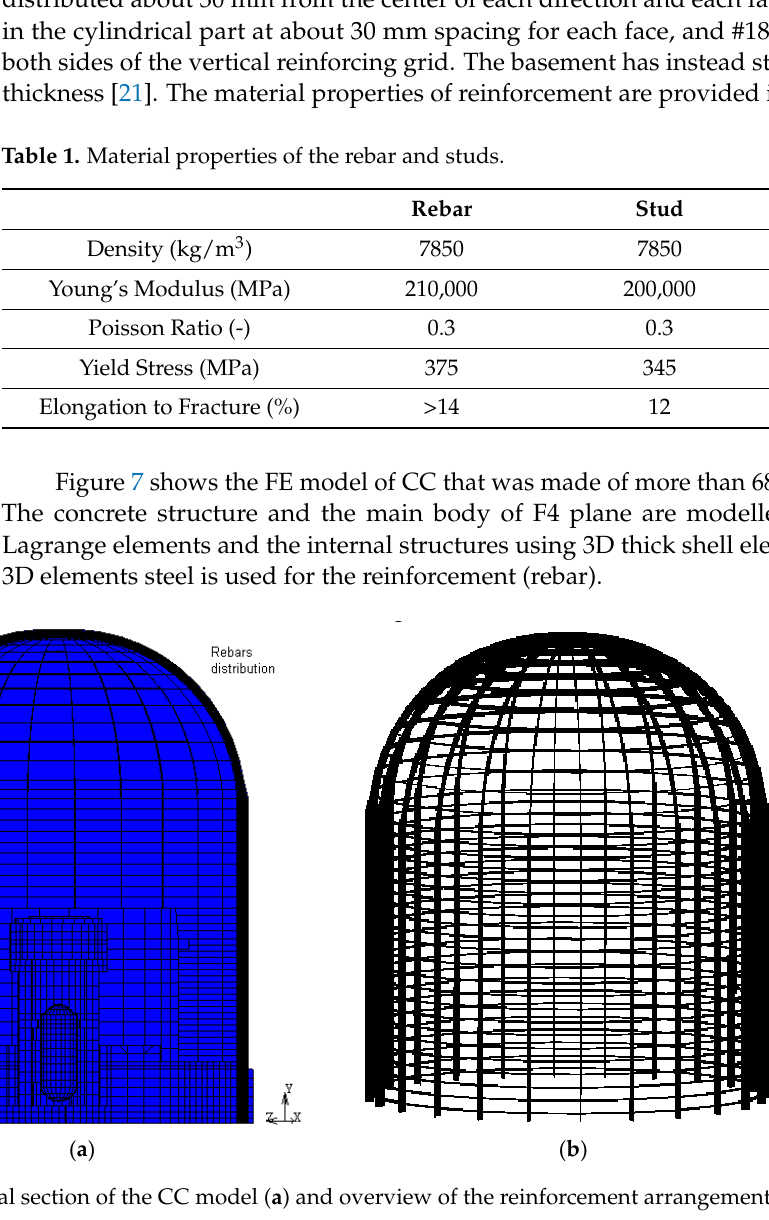
Table 1. Material properties of the rebar and studs.